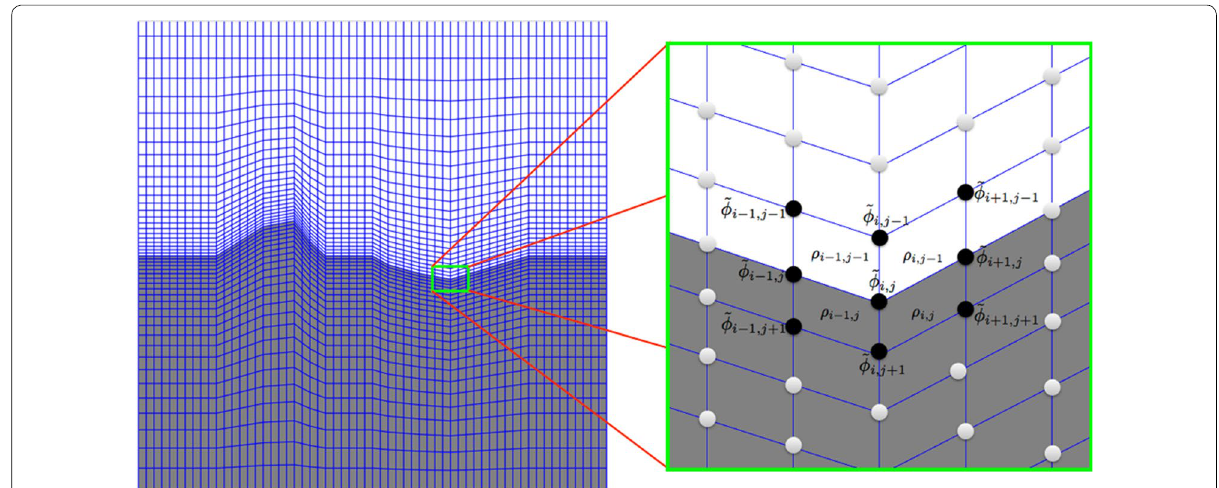
Fig. 2 The discretized model with quadrilateral elements (left). The approximation of field ˜ φ by using the eight neighbor nodes is demonstrated